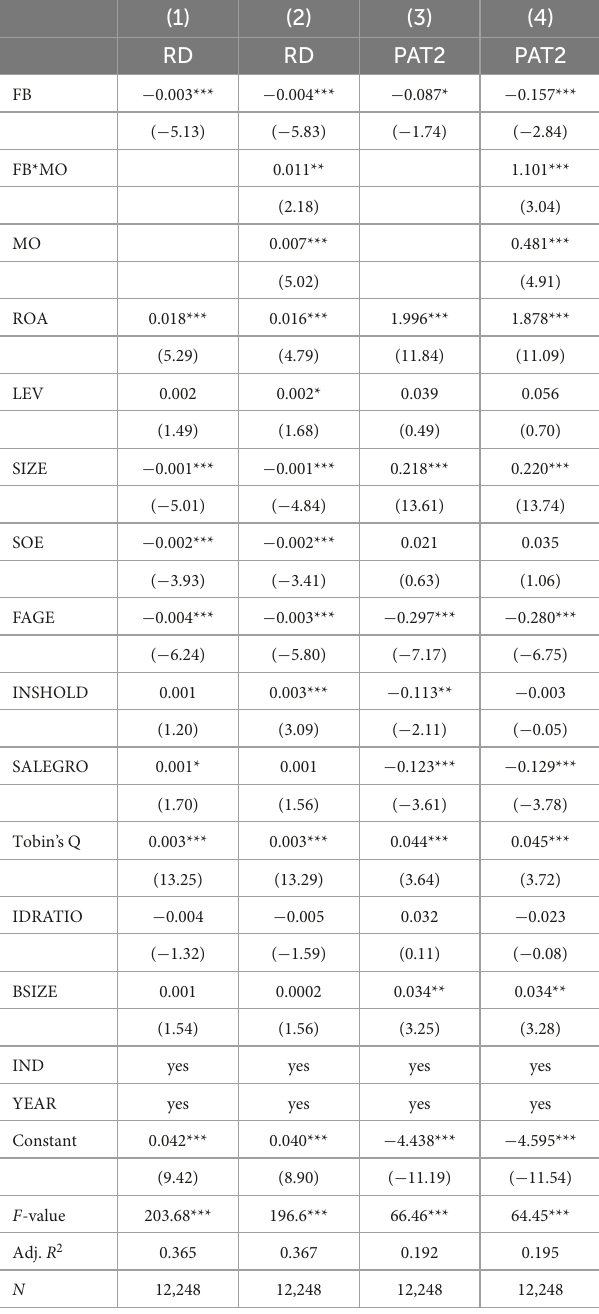
TABLE 5 Results of robustness check using an alternative dependent